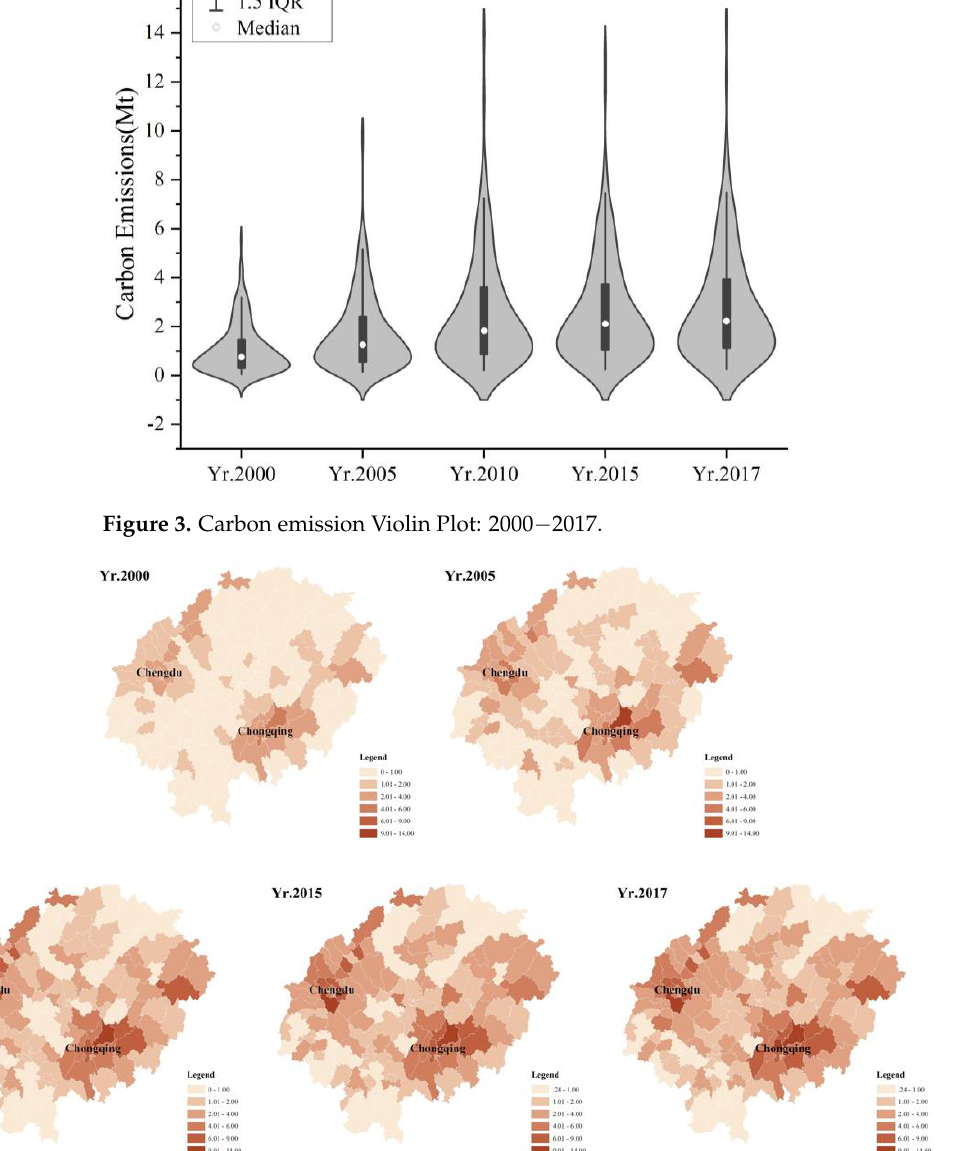
Figure 4. Carbon emissions distribution map: 2000 − 2017.